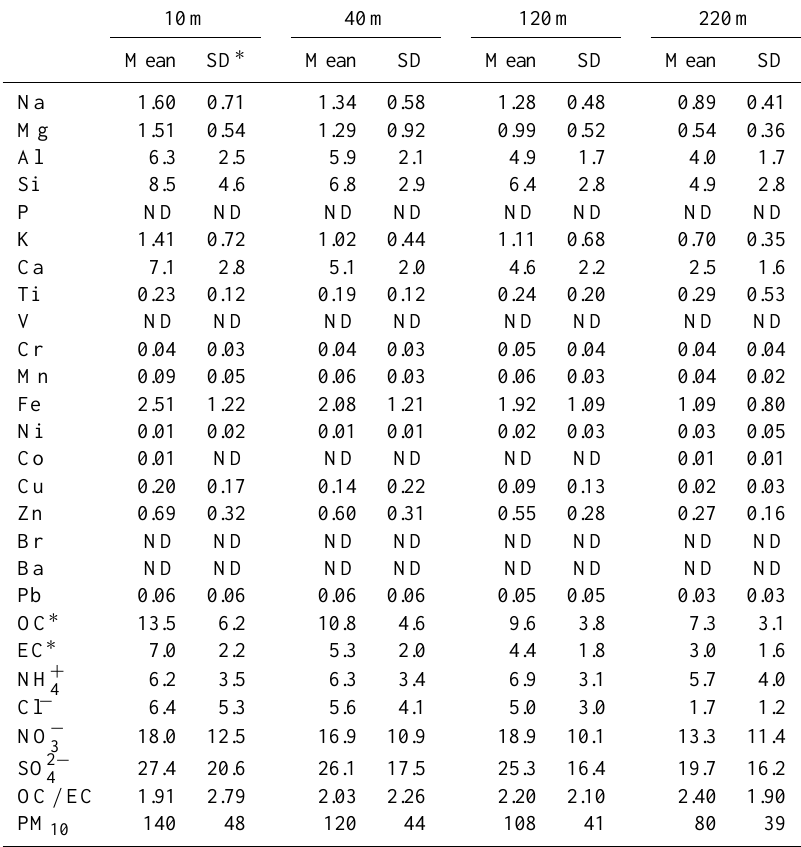
Table 3. The concentration of chemical composition in ambient PM 10 at four height sampling sites (µgm − 3 )